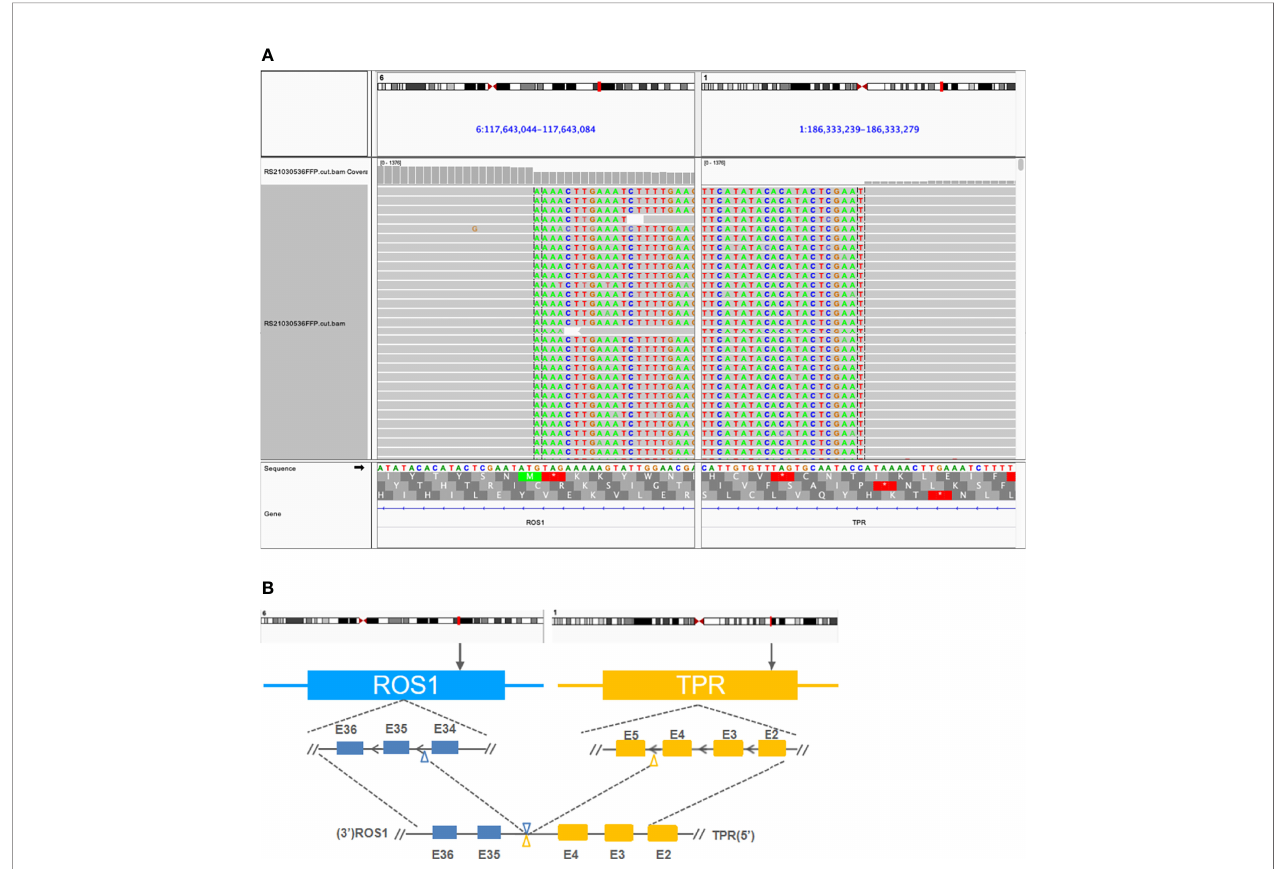
FIGURE 2 | Detection of a novel TPR-ROS1 (T4:R35) gene rearrangement using next-generation sequencing. (A) Identi fi cation of a TPR-ROS1 gene fusion. (B) Structural illustration of the resultant putative chimeric protein. TPR , translocated promoter